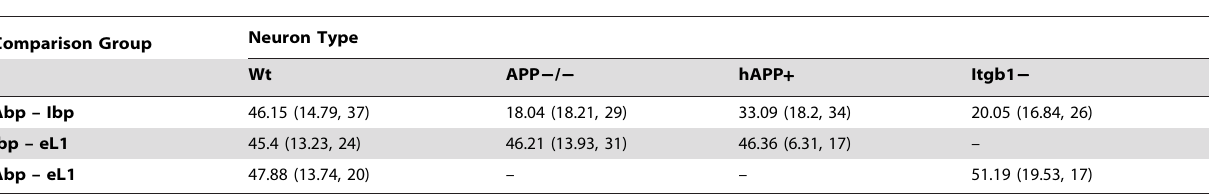
Table 8. Haptotactic Assays. Numerical Data: Mean % Cross-Over (SD, N).